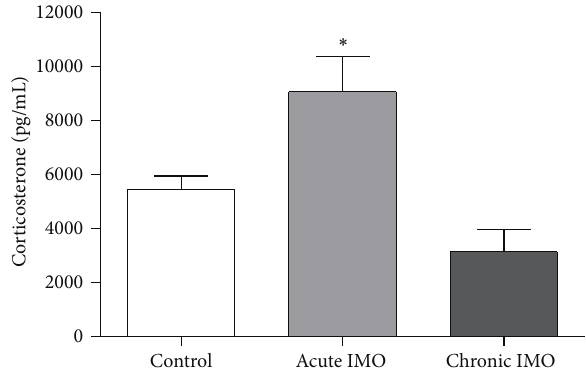
Figure 3: Mean ( ± SEM) CORT level in the plasma of the control, acute, and chronic IMO-submitted rats. Acute IMO significantly increased plasma CORT whereas chronic IMO induced reduction of CORT release. ( 𝑛 = 8 per group) ∗ 𝑃 < 0.05 versus control;